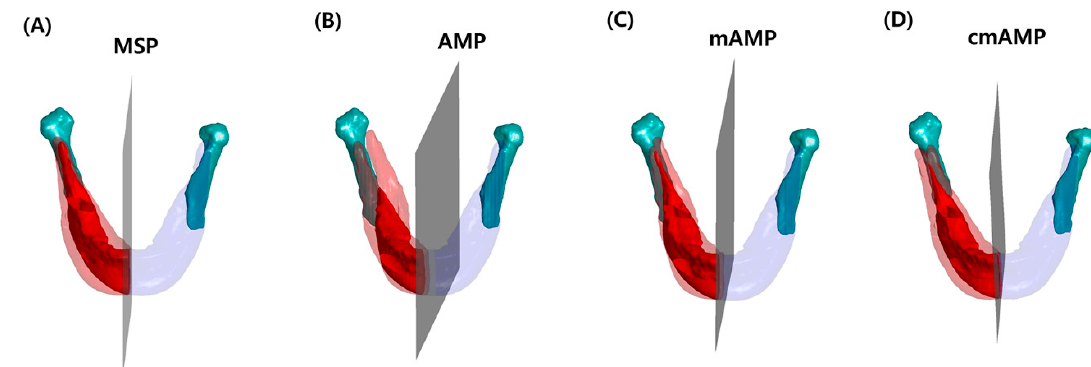
Figure 2. Segmentation of the hemi-mandible into anterior and posterior parts. The hemi-mandible was divided into anterior and posterior segments using a conventional osteotomy line for the intraoral vertical ramus osteotomy (IVRO) operation. The opaque section indicates overlapping volume and the translucent section indicates the non-overlapping volume, using each mandibular midsagittal plane in the anterior segment. ( A ) facial midsagittal plane (MSP); ( B ) absolute mandibular midsagittal plane (AMP); ( C ) modified absolute mandibular midsagittal plane (mAMP); and ( D ) computed modified absolute mandibular midsagittal plane (cmAMP).